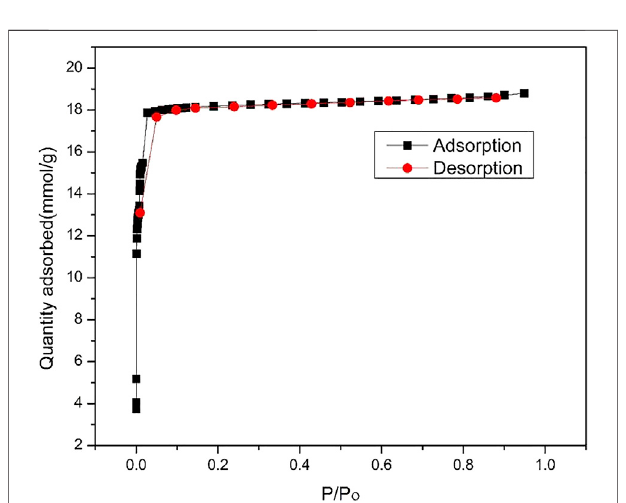
FIGURE 4 | PXRD of ZIF-67 after soaking in ethanol (red), THF (blue), and liquid H 2 O (purple) for 24